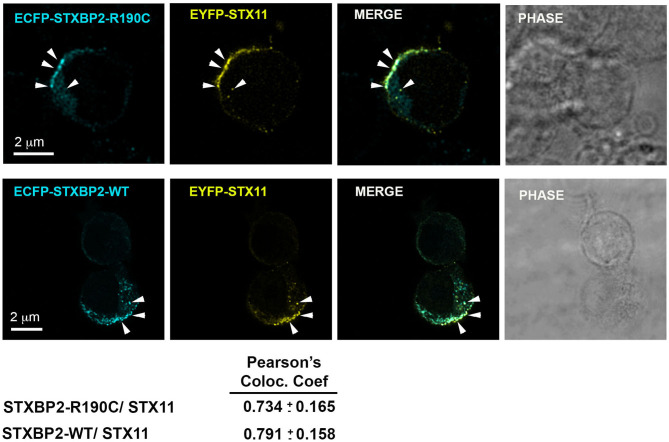
The R190C mutation does not affect the subcellular localization of STX11. CTLs from an H.C. individual were cotransfected with EYFP-STX11 and either ECFP-STXBP2-WT or ECFP-SXBP2-R190C; cells were incubated in the presence or absence of anti-CD3 coated P815 cells at a 1:1 ratio for 15 min at 37°C on polylysine-coated coverslips. Cells were fixed, mounted and imaged. Bars equal 2 μm. Pearson colocalization coefficient between ECFP-STXBP2-WT or R190C and EYFP-STX11. Values represent the mean ± SD; n = 15 cells.